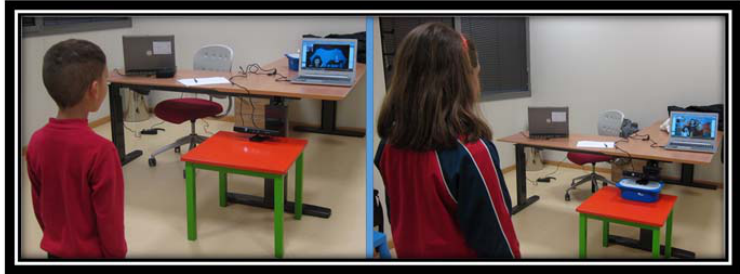
Figure 11. Verification Stage with typical development children.